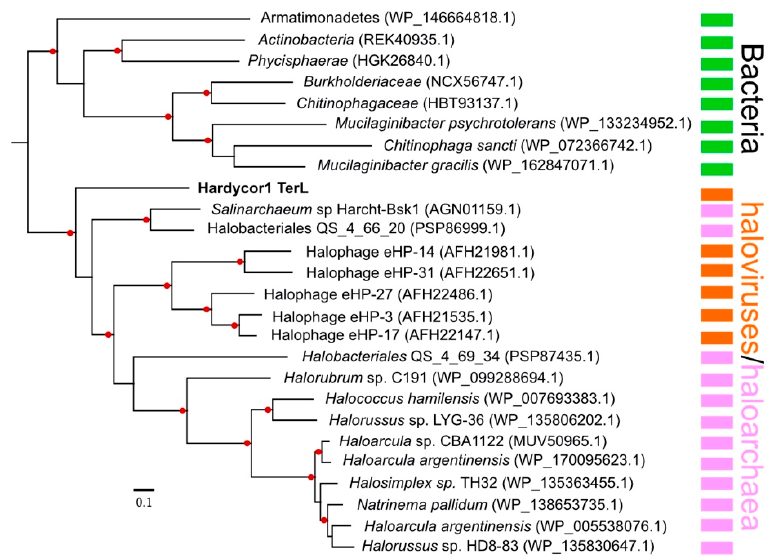
Figure 4. Phylogenetic tree reconstruction of Hardycor1 TerL protein. The top 100 BLASTp matching proteins were downloaded from the NCBI nr protein database, partial sequences and duplicates removed, and the remaining sequences imported into Geneious and aligned (MAFFT aligner). Trees were inferred using the FastTree algorithm (approximately maximum likelihood) within Geneious and default settings. A consensus tree (100 repetitions) was generated, with branch support values ≥ 80% indicated by red discs. Only part of the full tree is shown, the section that includes Hardycor1 TerL and closest related proteins. Genbank accessions are shown in brackets. Scale bar (lower left) represents 0.1 expected substitutions per site. Coloured bars indicate major taxonomic groups: green, bacteria; orange, haloviruses; pink, haloarchaea (class Halobacteria).